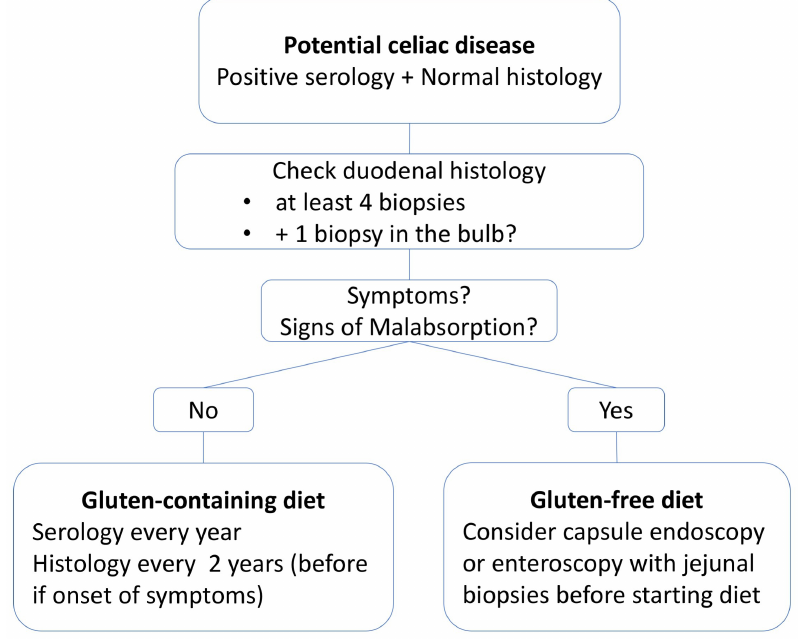
Figure 1. Rational approach to patients with potential